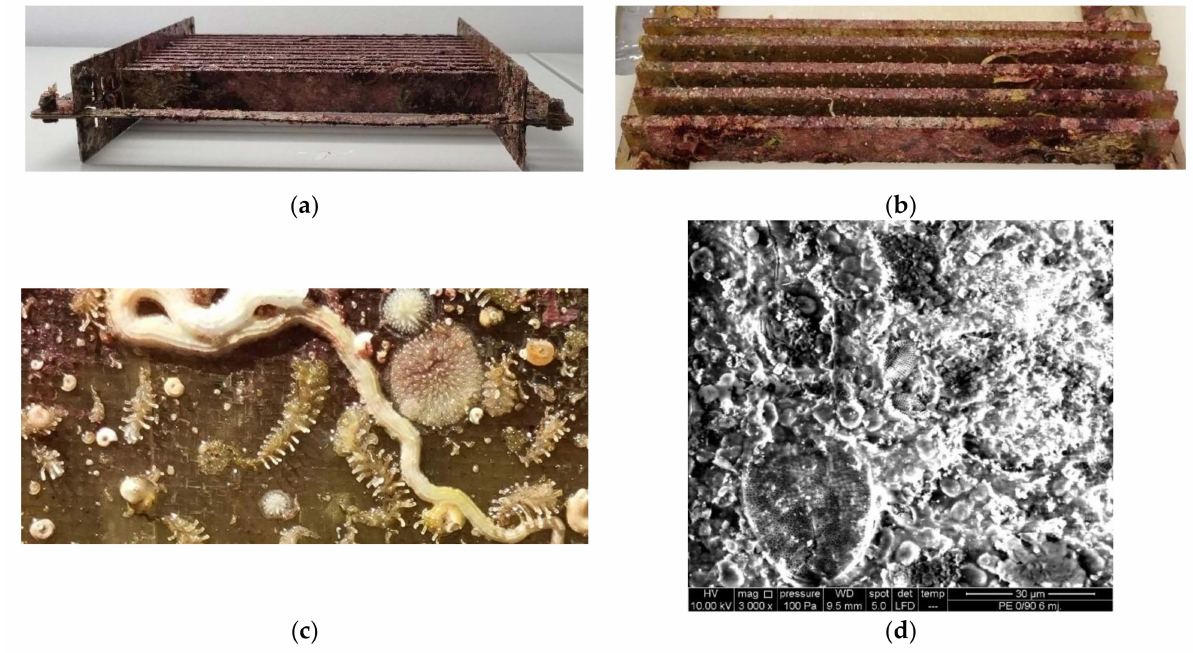
Figure 1. Attached bio-layer: ( a ) coupons in submerging fixture; ( b ) coupons after 2 years of submersion; ( c ) detail of marine organisms attached; ( d ) scanning electron image of embedded organisms after 6 months of